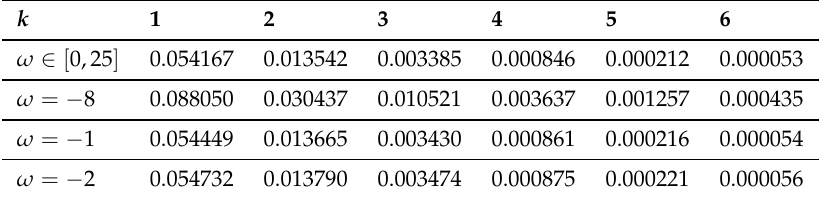
Figure 3. Error bounds of Quaternary scheme (Equation (18)). Table 3. Quaternary scheme error bounds.